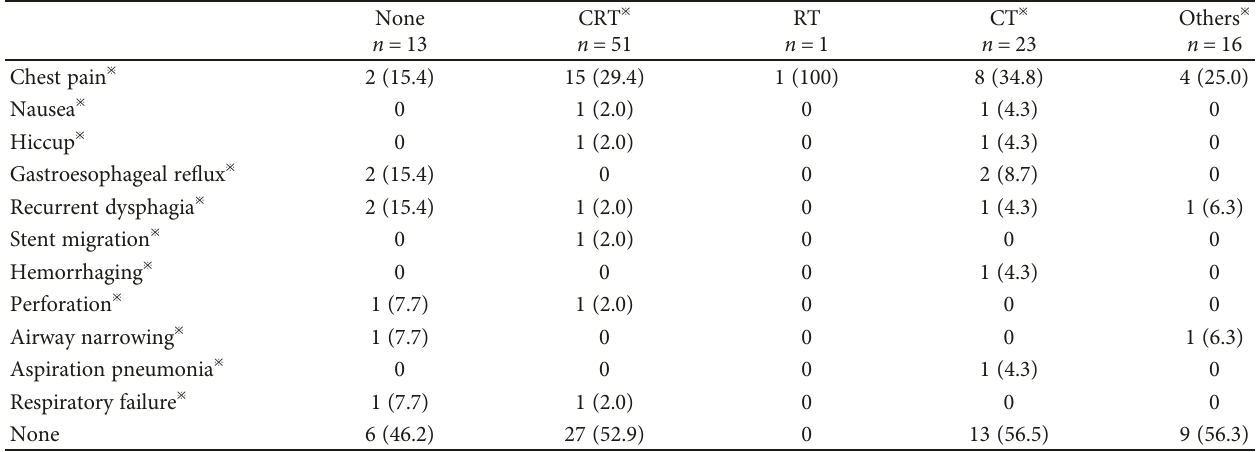
Table 4: Relationships between complications and prior treatment ( n = 91 times, number (%)).